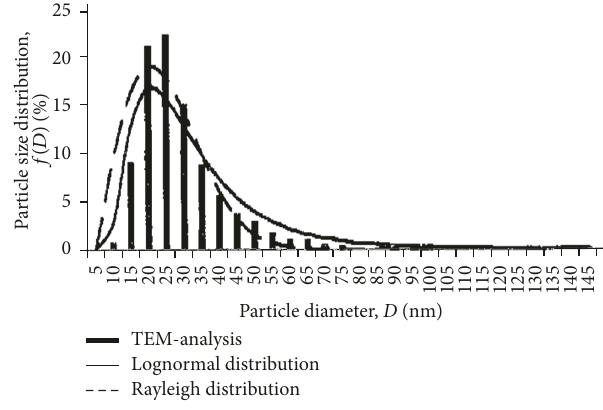
Figure 3: Particle size distribution for the PSNP obtained from the TEM data